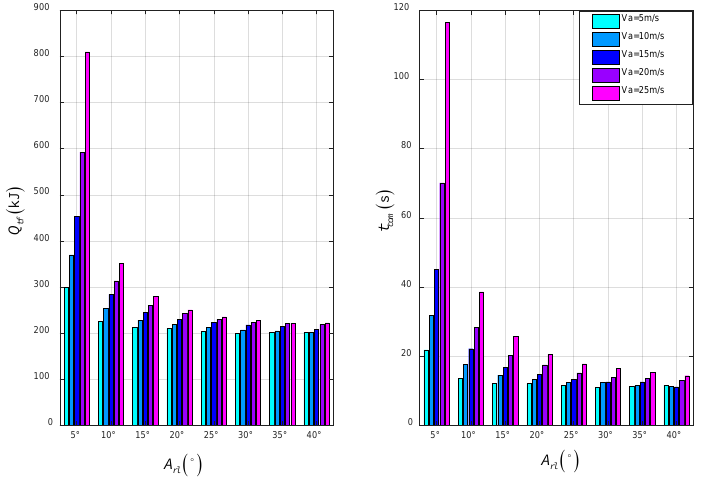
Figure 20. The total energy consumption and time in STO.